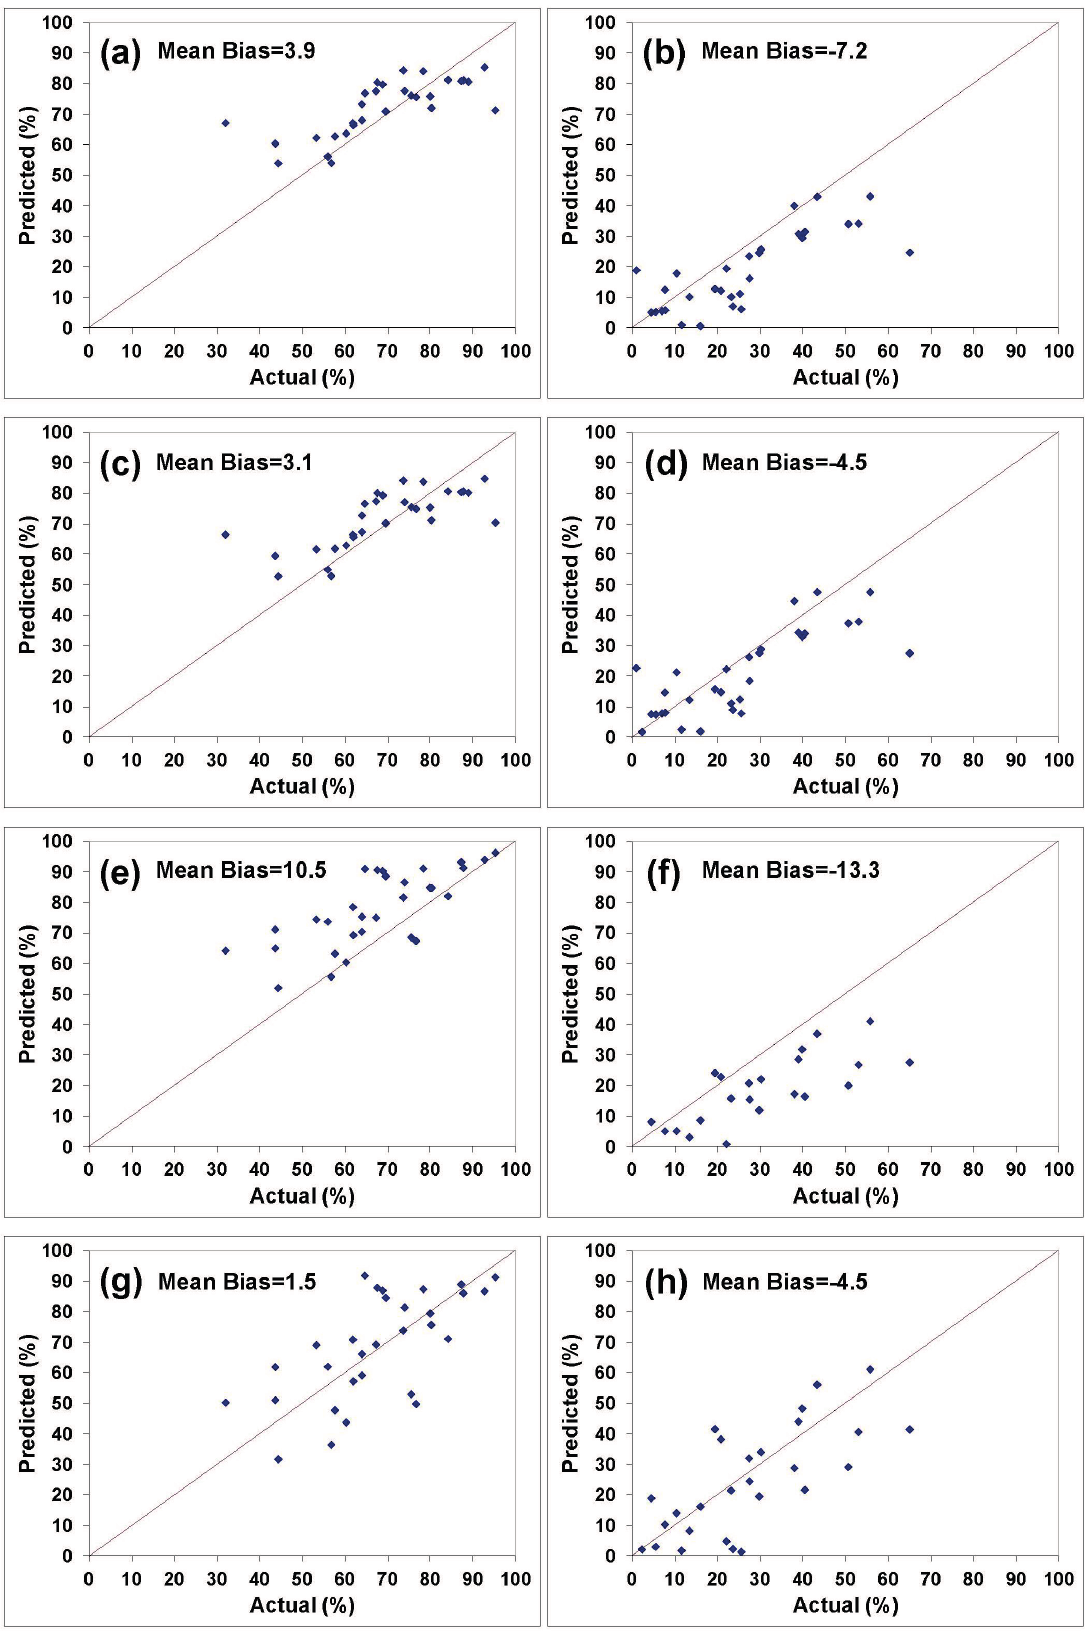
Figure 8. Actual vs. Predicted Plots for Stand Size Classes Prediction Models: ( a ) Sawtimber (FD), ( b ) Saplings (FD), ( c ) Sawtimber (FD, Elevation), ( d ) Saplings (FD, Elevation), ( e ) Sawtimber (I), ( f ) Saplings (I), ( g ) Sawtimber (I, Elevation), ( h ) Saplings (I,